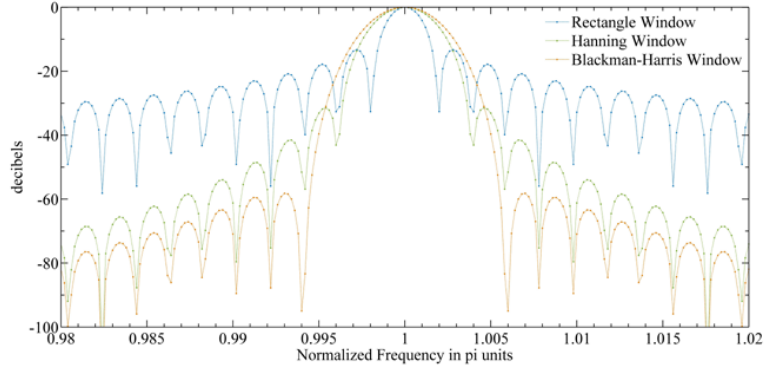
Figure 18. Three commonly used window functions for fast Fourier transform (FFT) weighting.